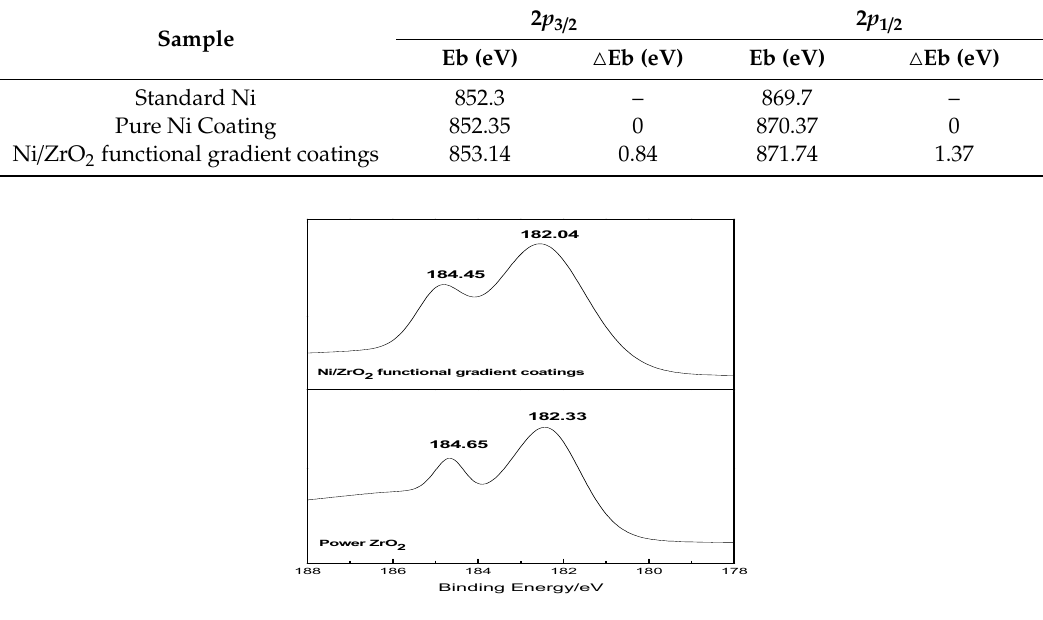
Figure 14. XPS spectrum of Ni element. Table 7. 2 p electron bonding energies of each Ni coating.